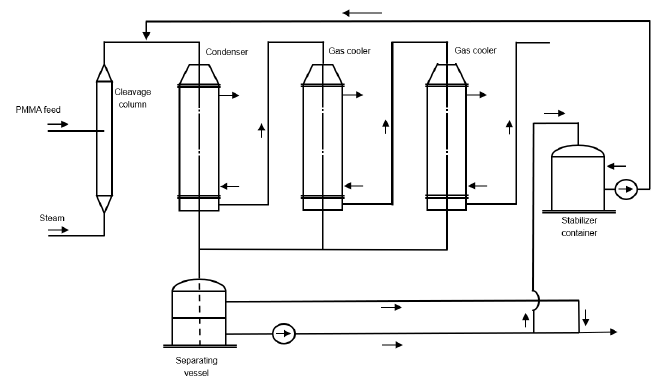
Figure 19. Configuration for the chemical recycling of PMMA as developed by Mannsfeld et al. based on counter current reactor technology [130] .